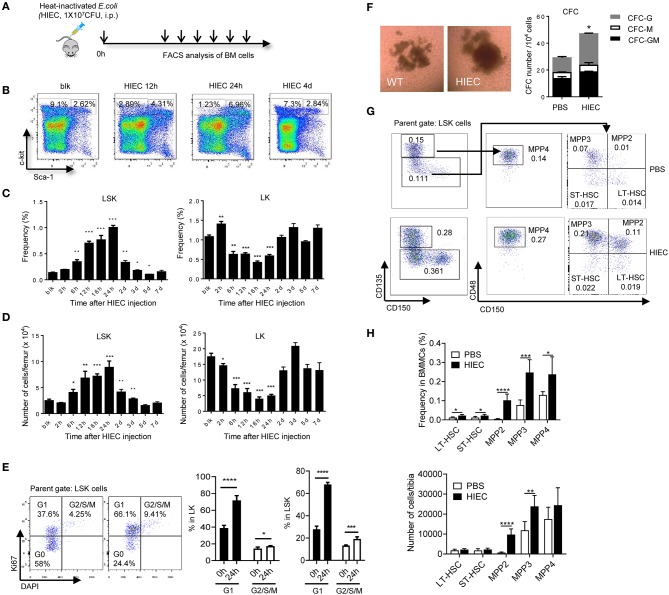
HIEC-elicited acute inflammation triggers expansion of lineage–sca-1+c-kit+ (LSK) cells. (A) Experimental scheme for the in vivo HI E. coli challenge experiments. Heat-inactivated E. coli (HIEC, 1 × 107 CFU) were injected intraperitoneally. At each time point, BM cells were collected and analyzed by FACS. (B) Representative FACS plots showing changes in LK and LSK cell frequency in BM mononuclear cells at different time points after HIEC challenge. (C) Percentage of LSK and LK cells in BM mononuclear cell (BMMC) populations at different time points after E. coli challenge. Data shown are means ± SD (n = 4 mice). *p < 0.05, **p < 0.01, ***p < 0.001, ****p < 0.0001 vs. unchallenged mice (blk). (D) Absolute number of LSK and LK cells in the total BM at different time points after E. coli challenge. Data shown are means ± SD (n = 4 mice). *p < 0.05, **p < 0.01, ***p < 0.001, ****p < 0.0001 vs. unchallenged mice (blk). (E) Percentage of G1 and G2/S/M cells in LK and LSK cells 24 h after the HI E. coli challenge. Data shown are means ± SD (n = 5 mice). *p < 0.05, **p < 0.01, ***p < 0.001 vs. unchallenged mice (time 0). (F) The number of committed myeloid progenitors analyzed using a quantitative granulocyte–monocyte colony-forming unit (CFU-GM) assay. BMMCs were prepared 24 h after E. coli injection and cultured in MethoCult™ GF M3434 medium for 7 days. Representative photographs of cell clusters/colonies are shown. The number of granulocyte colony-forming units (CFU-G), monocyte colony-forming units (CFU-M), and granulocyte–monocyte colony-forming units (CFU-GM) from 10,000 BMMCs were calculated. Data shown are mean ± SD of n = 3 mice. *p < 0.01 vs. PBS-treated mice. (G) Representative FACS plots showing HSC/HPC subpopulations. LT-HSC (CD135−CD150+CD48−LSK), ST-HSC (CD135−CD150−CD48−LSK), MPP2 (CD135−CD150+CD48+LSK, myeloid-biased), MPP3 (CD135−CD150−CD48+LSK, myeloid-biased), and MPP4 (CD135+CD150−CD48+LSK, lymphoid-primed) cell populations were defined as previously reported (54). (H) Percentage of LT-HSC, ST-HSC, MPP2, MPP3, and MPP4 cells in BM mononuclear cell (BMMC) population and their absolute number in tibia 24 h after the HI E. coli challenge. Data shown are means ± SD (n = 5–7 mice). *p < 0.05, **p < 0.01, ***p < 0.001, ****p < 0.0001 vs. control (PBS treated).